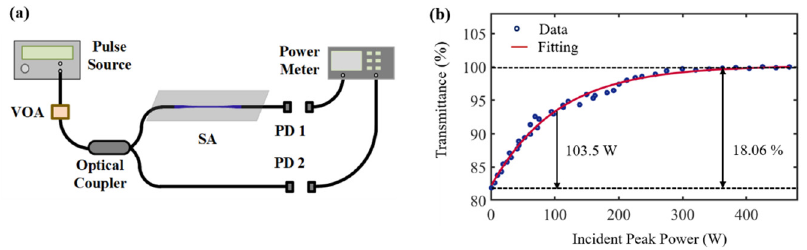
Figure 3. ( a ) balanced twin-detection system; ( b ) Saturation absorption